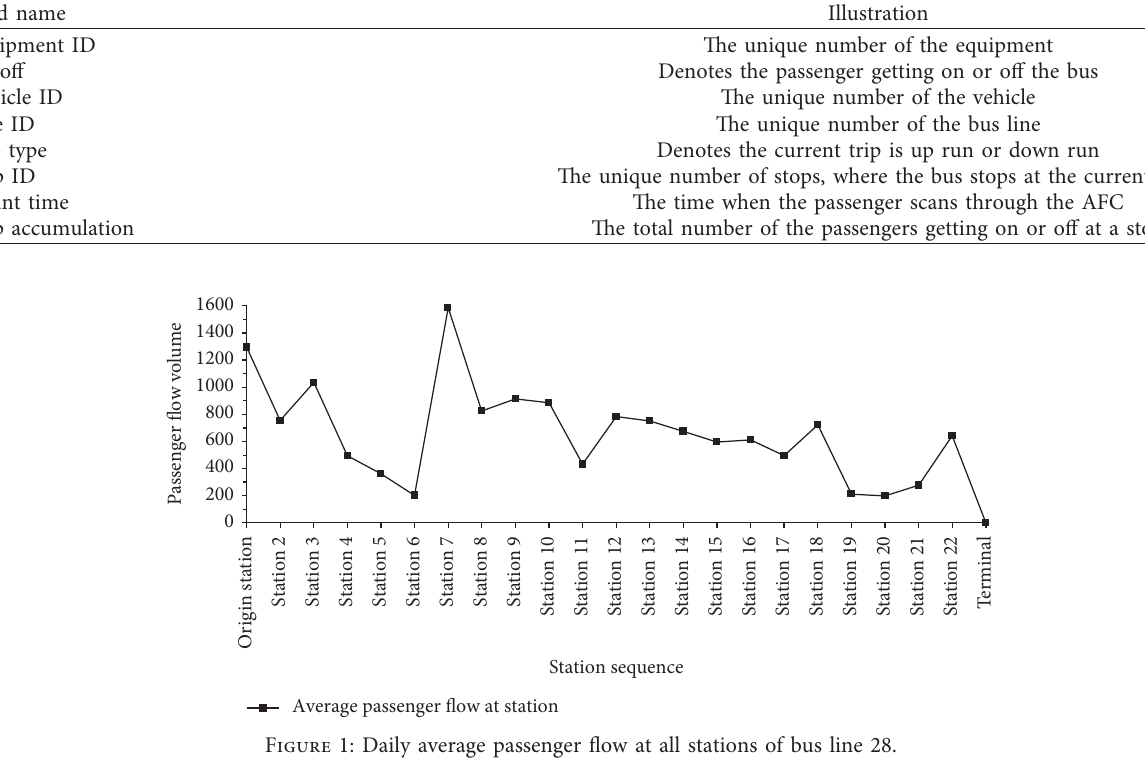
Table 1: The structure of the record from the automatic passenger counters (APCs).